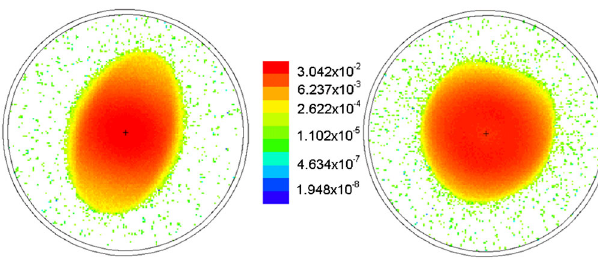
FIG. 9. Beam profile for the reference and rotated cases before the target